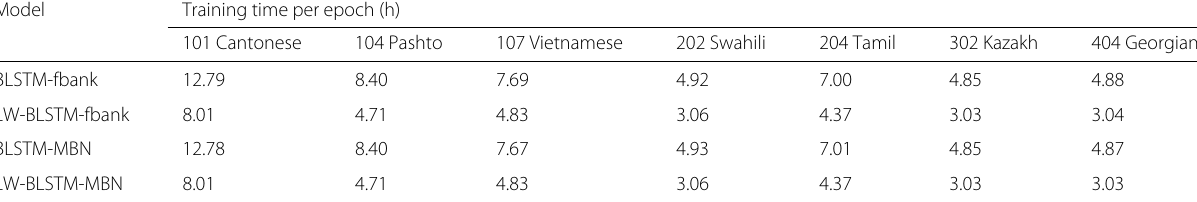
Table 10 Training time per epoch (hours) of BLSTMs and LW-BLSTMs for all languages Model Training time per epoch (h) 101 Cantonese 104 Pashto 107 Vietnamese 202 Swahili